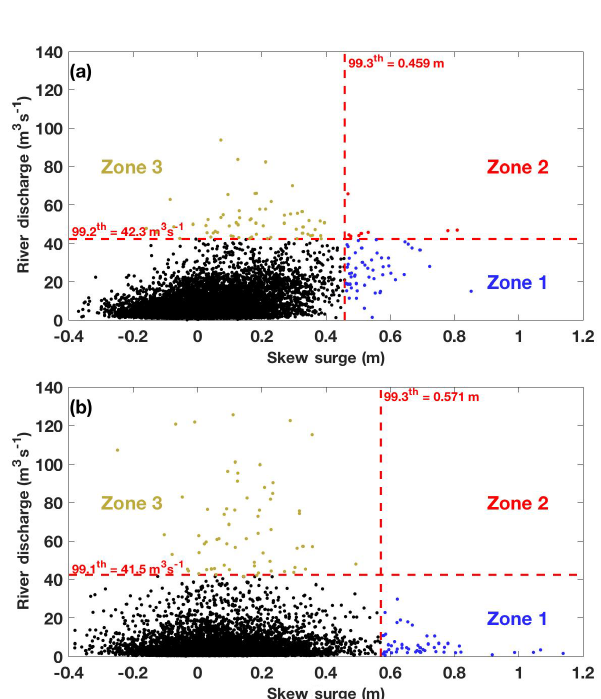
Figure 2. Daily maximum skew surge plotted against daily maxi- mum river discharge for (a) Devonport and (b) Whitby. The dotted red lines indicate the high percentiles chosen in the analysis for the two variables at these sites. Red dots (plotted in Zone 2) show the events with potential for compound flooding (i.e. joint occurrence of high storm surge and large river discharge), whereas blue (Zone 1) and green (Zone 3) dots define the non-compound events (i.e. high storm surge or high river discharge only,